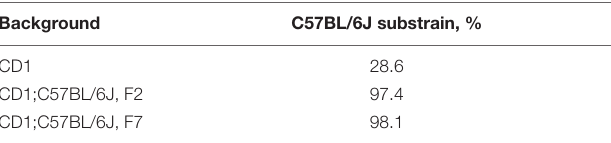
TABLE 2 | Percentage of diagnostic alleles present in C2cd3 ex2 / + mice on CD1 and C57BL/6J backgrounds.